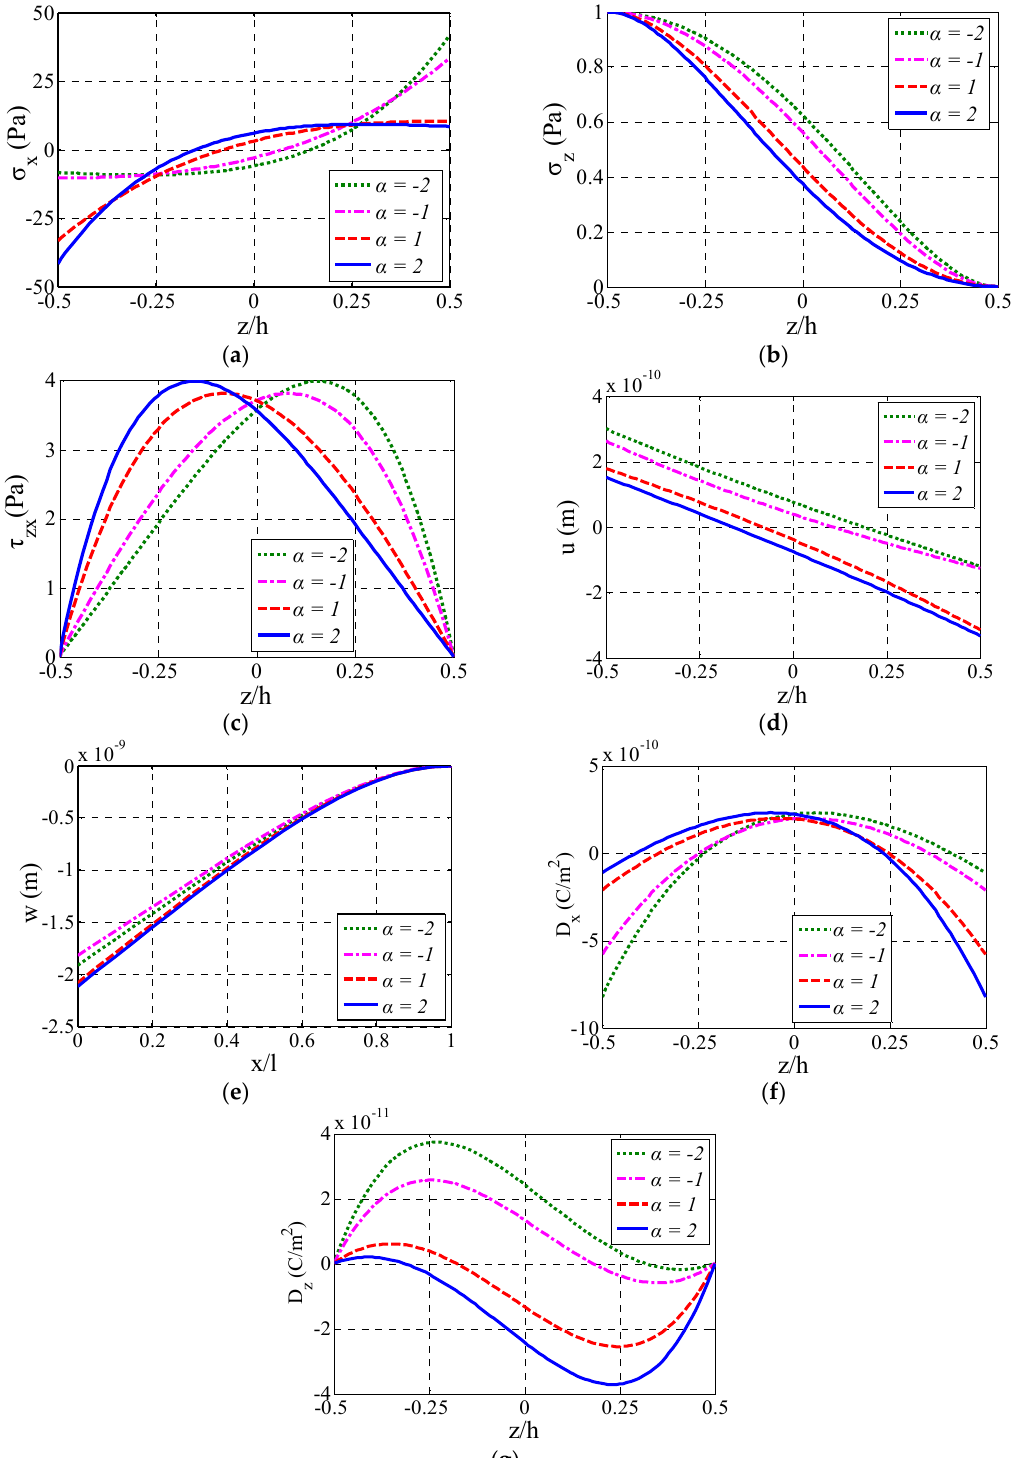
Figure 3. Variation of stresses, displacements, and electric displacements: ( a ) Variation of σ x with z / h at x = l /2; ( b ) Variation of σ z with z / h at x = l /2; ( c ) Variation of τ zx with z / h at x = l /2; ( d ) Variation of u with z / h at x = l /2; ( e ) Variation of w with x / l at z = 0; ( f ) Variation of D x with z / h at x = l /2; ( g ) Variation of D z with z / h at x = l